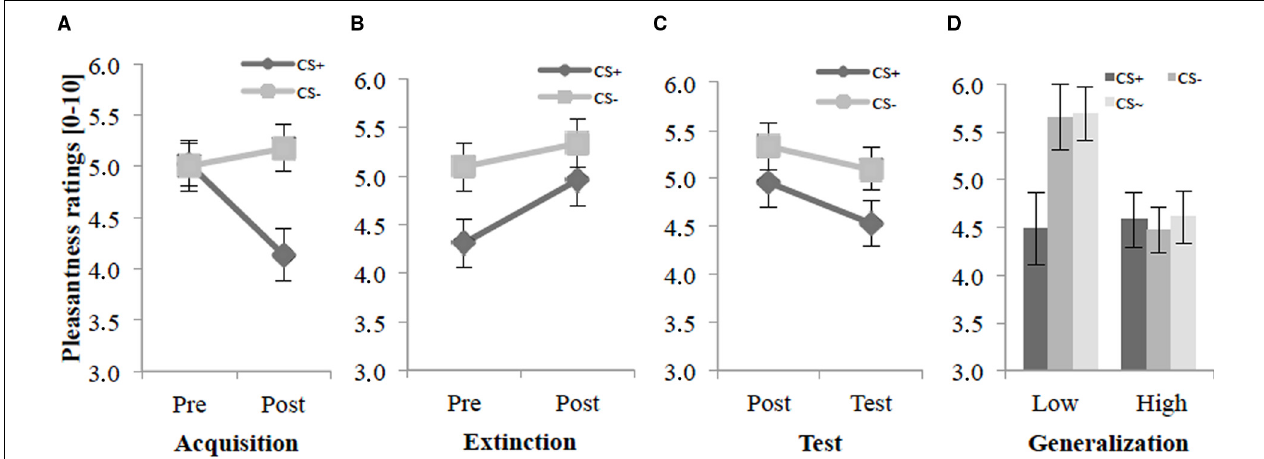
FIGURE 2 | Pleasantness ratings ( n = 40) for CS + and CS (cid:0) pre and post acquisition (A), extinction (B), and test phase (C) as well as the generalization effect (D) for CS + , CS (cid:0) and CS (cid:24) during test phase for low and high socially fearful participants. Note: CS + , agents with aversive unconditioned stimulus (US); CS (cid:0) , agents without aversive US; CS (cid:24) , new agents on the 2nd day without aversive US; Pre, before each phase; Post, after each phase; Test, test phase. Mean pleasantness ratings (0 = least pleasant to